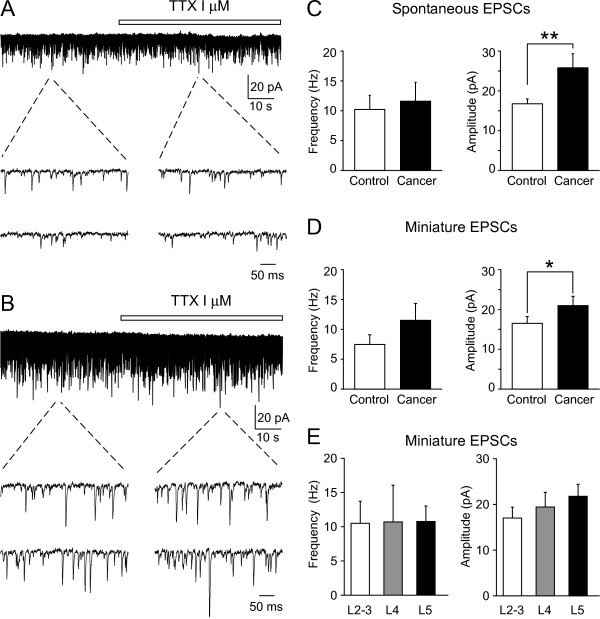
Spontaneous and miniature EPSCs evoked in SG neurons at lumbar spinal levels in control and cancer-bearing mice. Representative traces of sEPSCs and mEPSCs in control (A) and cancer-bearing mice (B). Horizontal bars given above the traces show the duration of drug application. Two lower records in A and B: consecutive traces of EPSCs in the absence (right) and presence (left) of TTX shown in an expanded scale in time. The frequency (left) and amplitude (right) of sEPSCs (C) and mEPSCs (D) in SG neurons at spinal levels of L3-5. The amplitudes of sEPSCs and mEPSCs were significantly larger in cancer-bearing than control mice, *P < 0.05 (unpaired t-test). The frequency and amplitude of mEPSCs at different lumber levels (L2-3, n = 5; L4, n = 6; L5, n = 12) in cancer-bearing mice (E). There were no significant differences in the frequency and amplitude of mEPSCs between the three groups. Values represent means ± S.E.M.